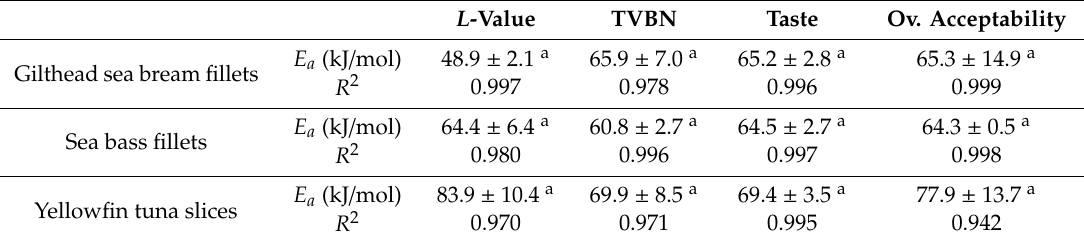
Table 1. Activation energy values ( E a ) for the quality deterioration rates of frozen gilthead sea bream fillets, sea bass fillets and yellowfin tuna slices stored in the range of − 5 to − 15 ◦ C (calculated value ± 95% confidence intervals based on the statistical variation of the kinetic parameters of the Arrhenius model—regression analysis).